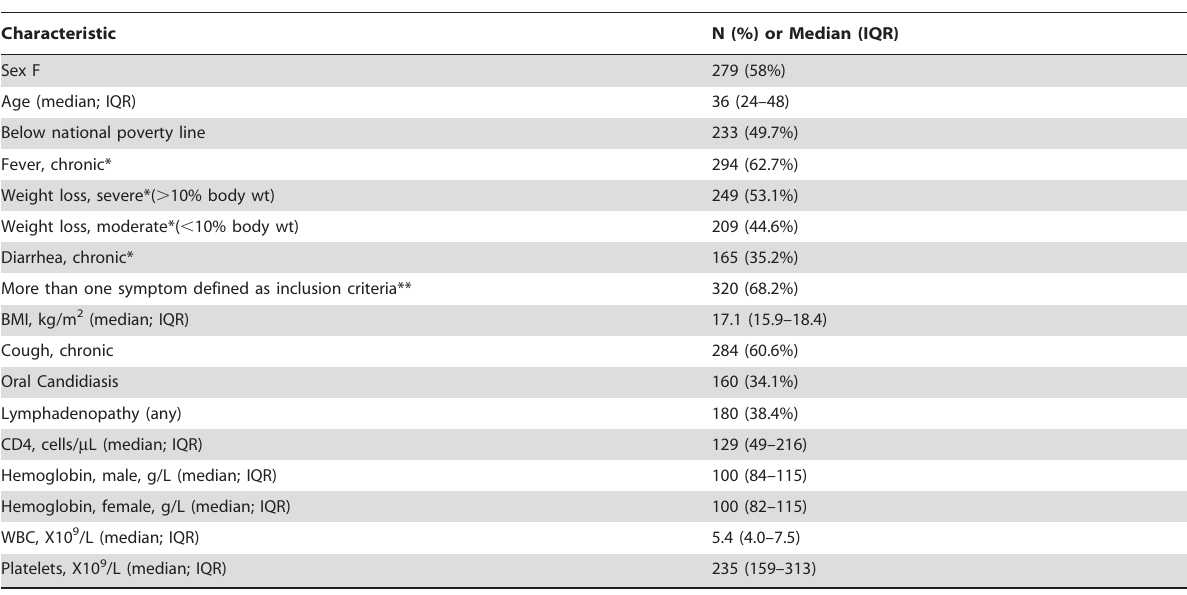
Table 1. Enrolment characteristics of 469 study subjects.